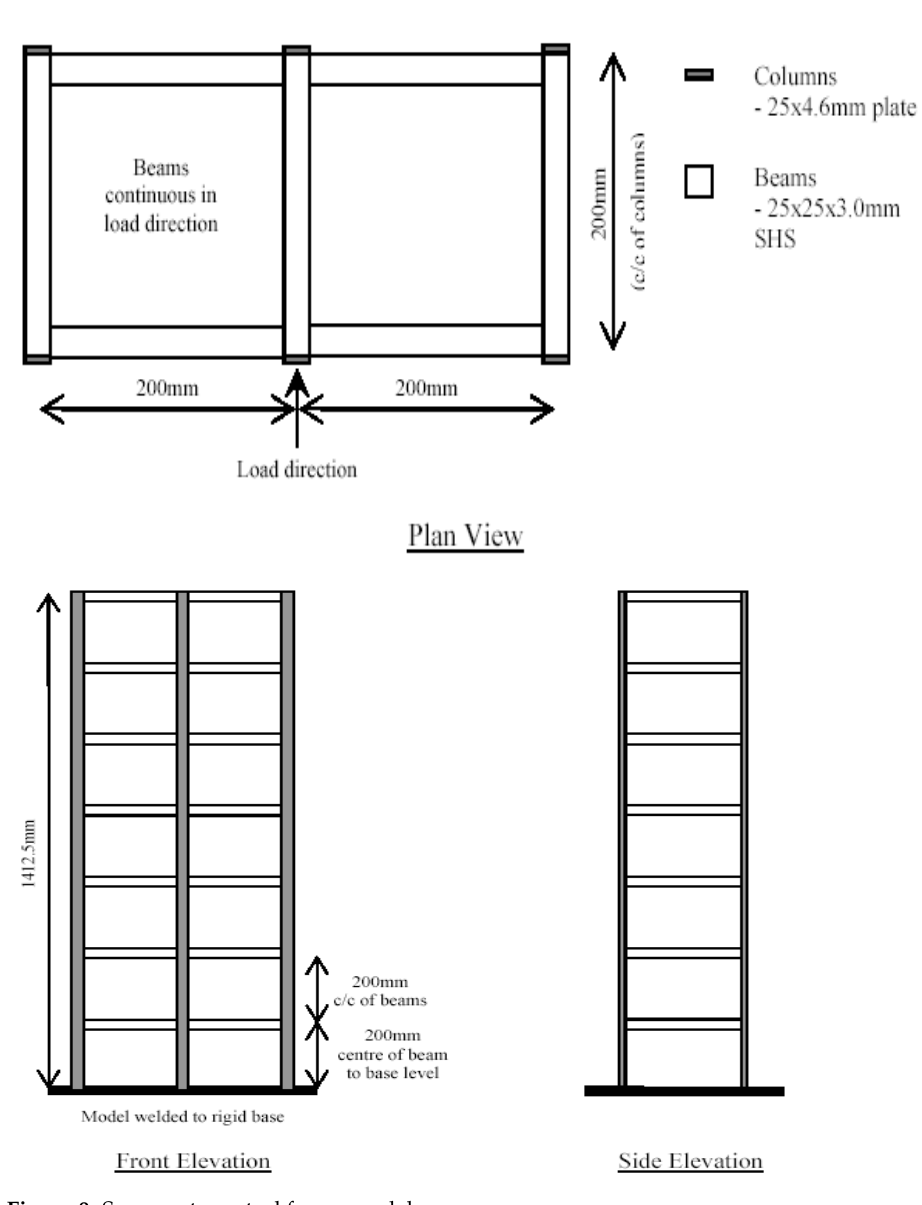
Figure 9. Seven − story steel frame model. Figure 9. Seven−story steel frame model. Table 1. Structural member